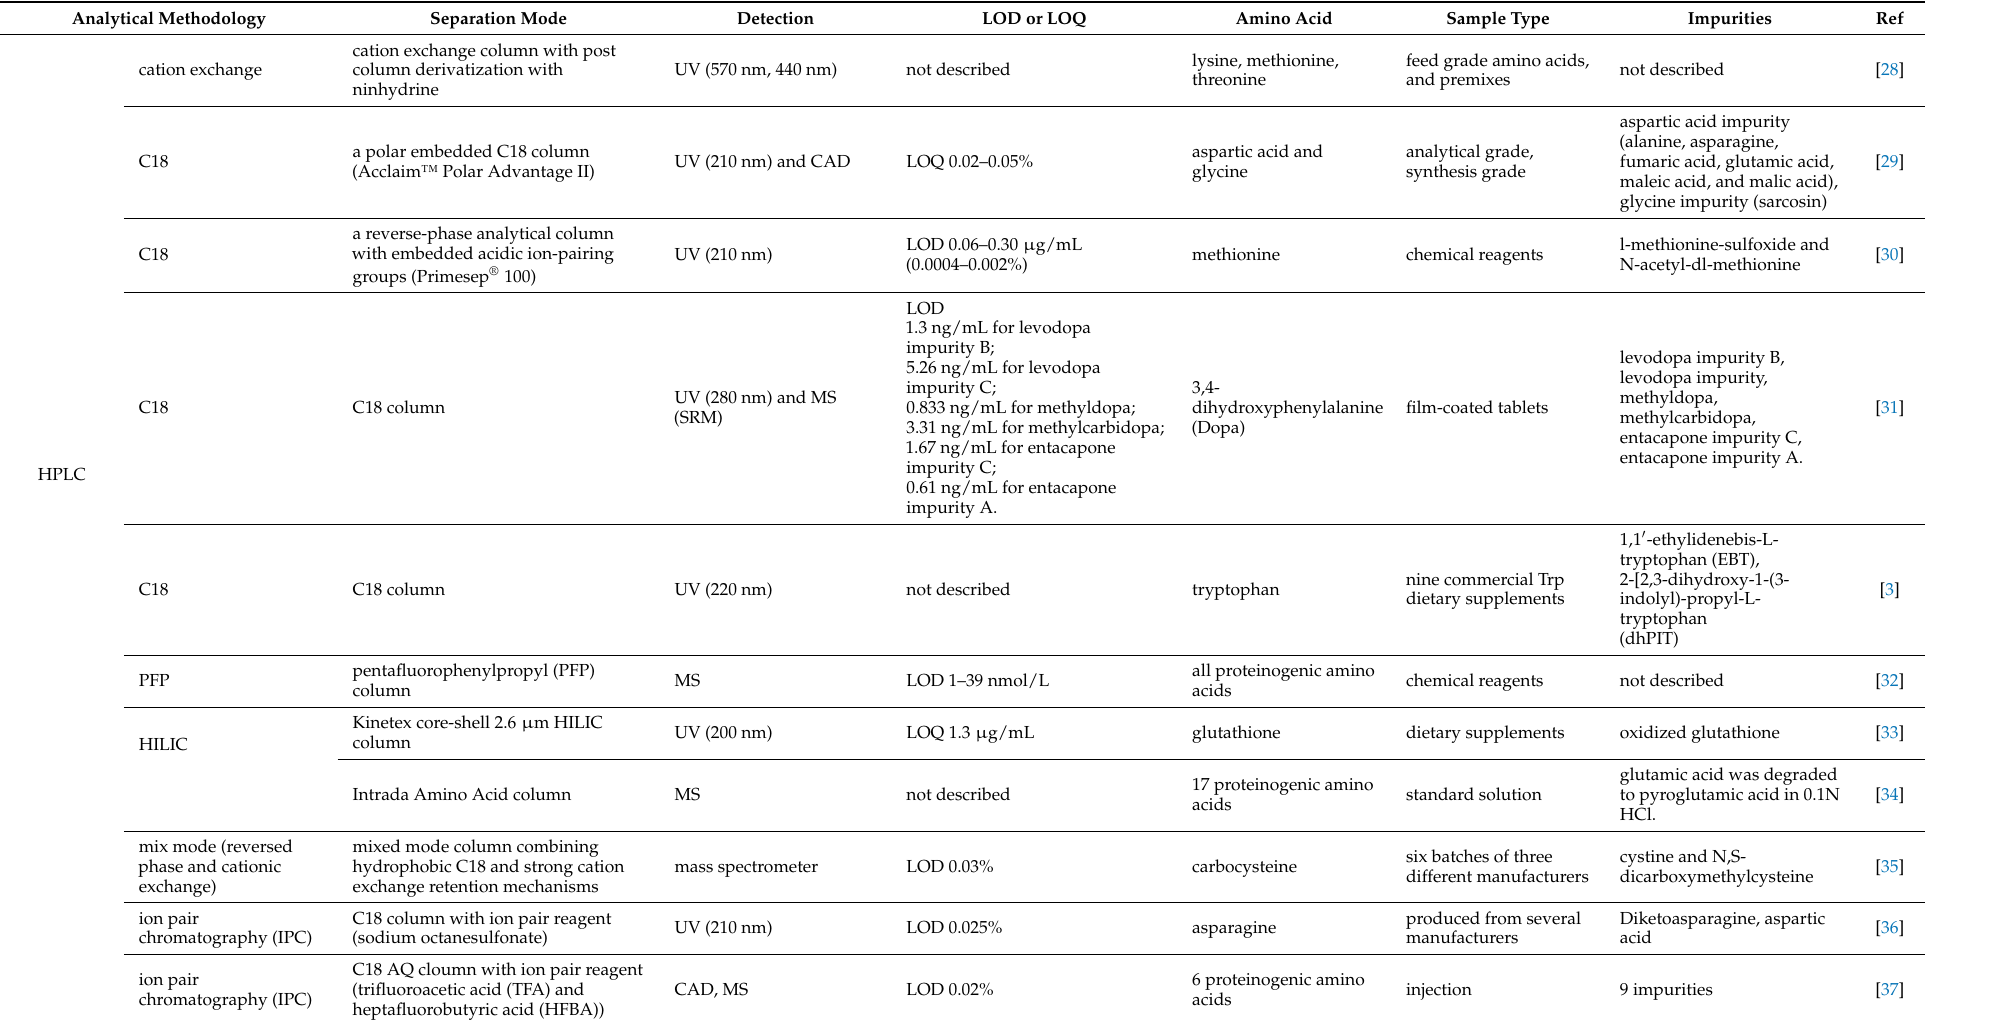
Table 1. Summary of analytical methods for detecting amino acid